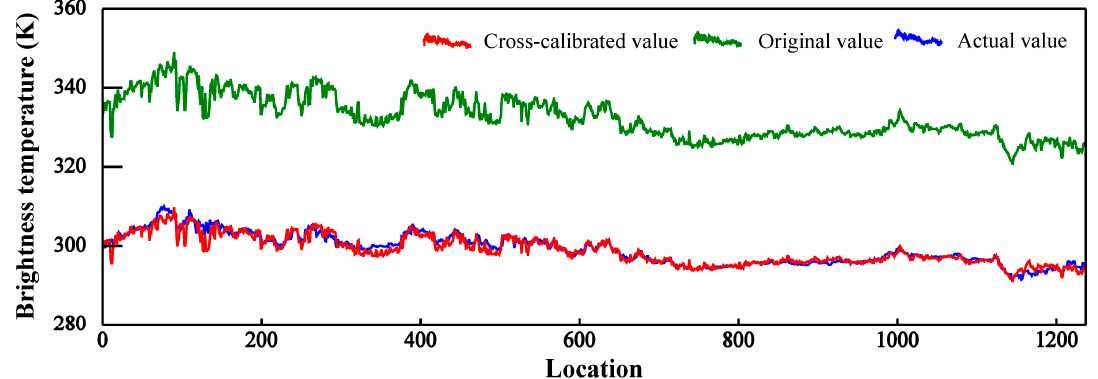
Figure 8. Comparison of the BT of MERSI-2 Band 25 before and after cross-calibration.